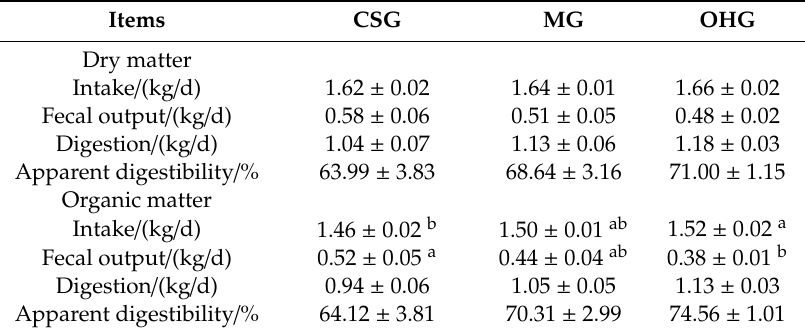
Table 3. E ff ects of dried oat hay content in diet on DM and organic matter (OM) apparent digestibility of sheep.